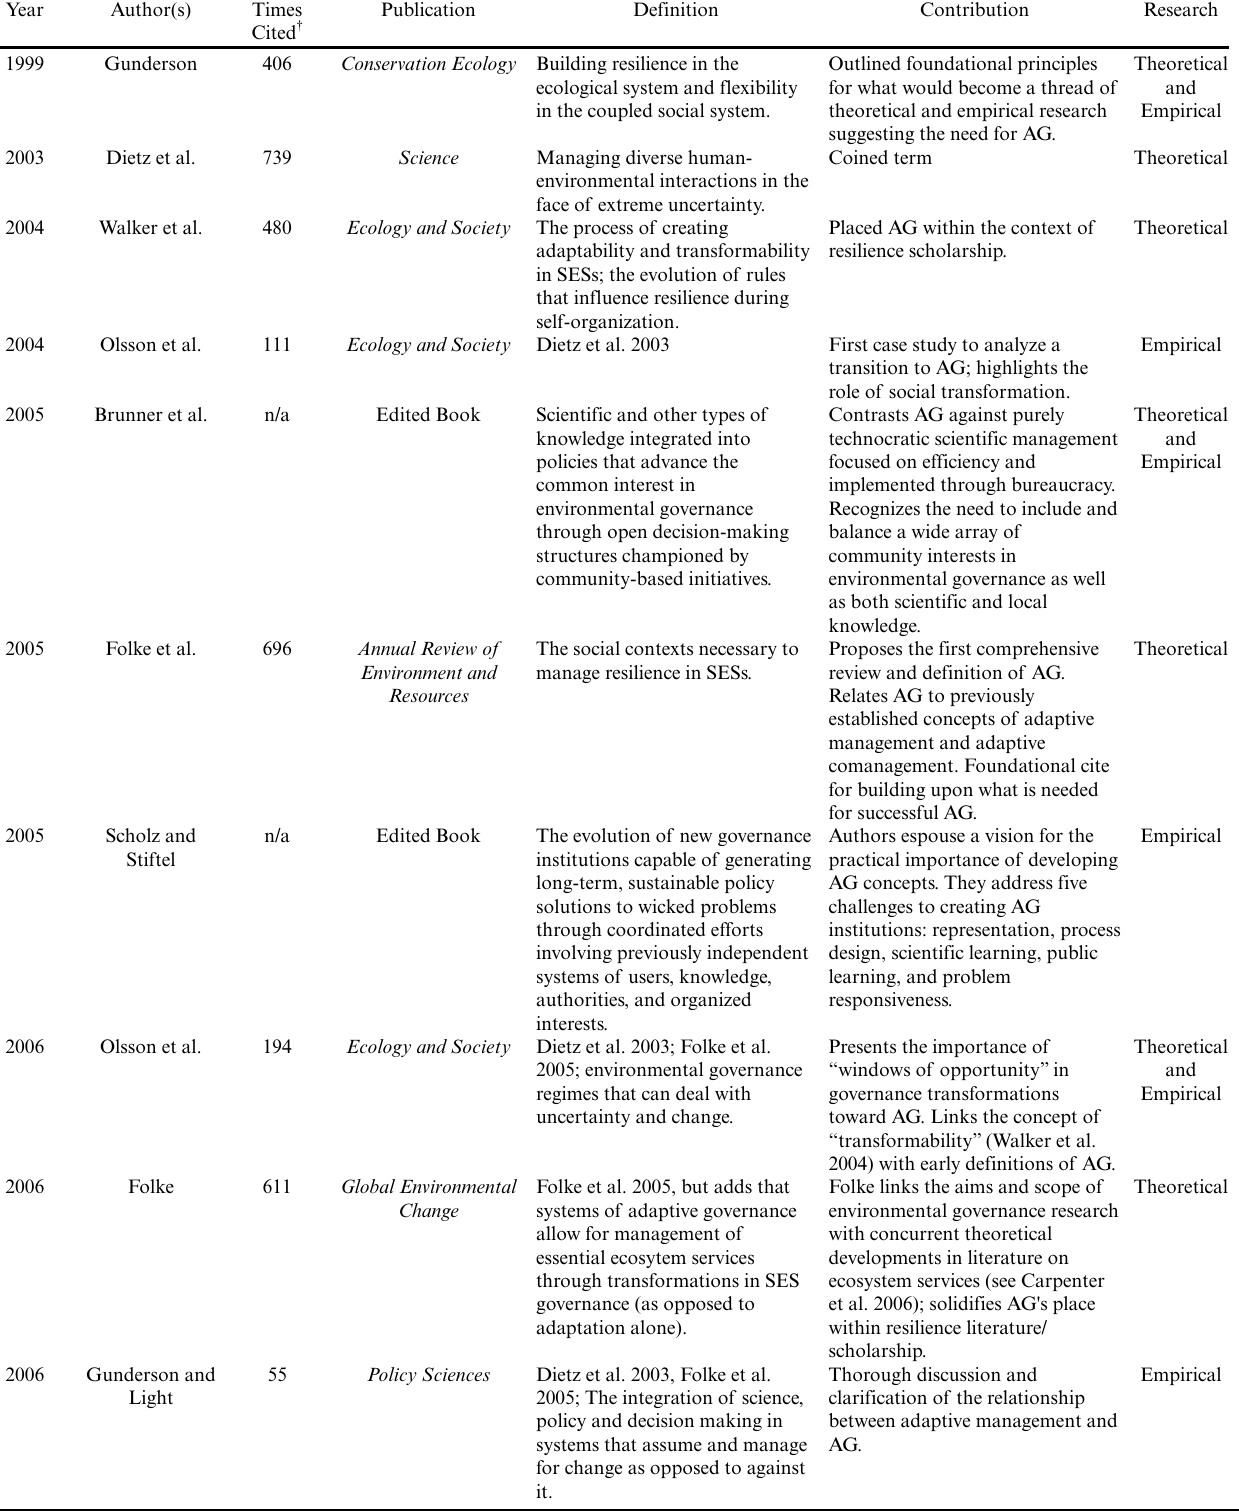
Table 1 . A timetable for foundational references defining adaptive governance